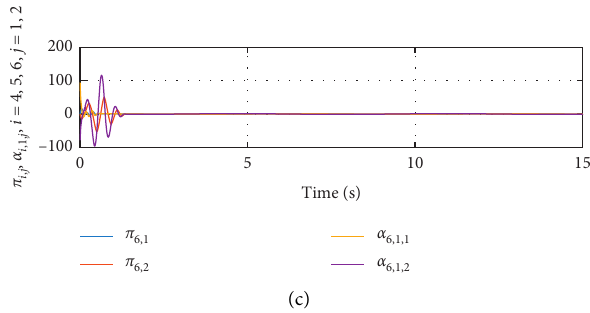
Figure 4: Response curves of π